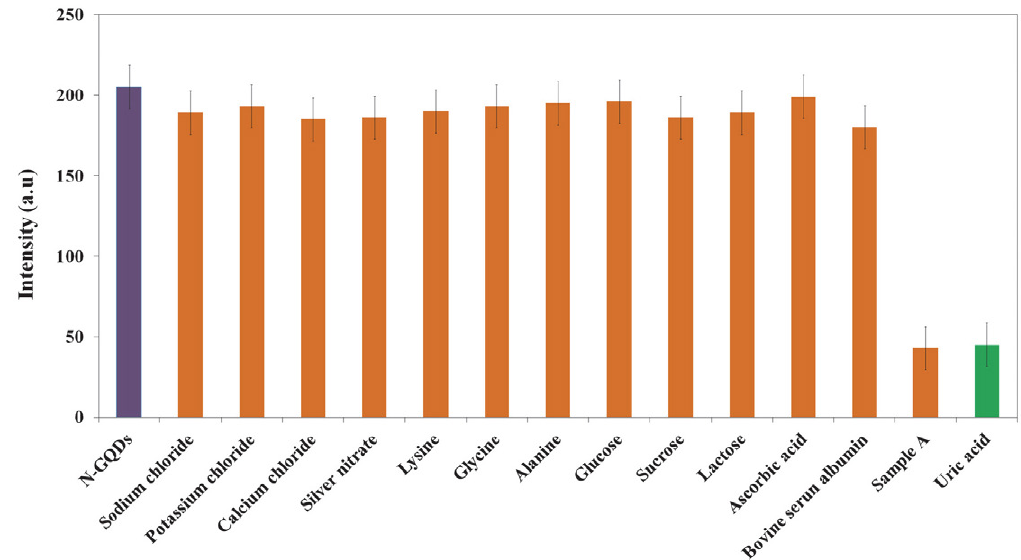
Figure 7: Fluorescence intensity (n = 3) in presence of different ions and biomolecules